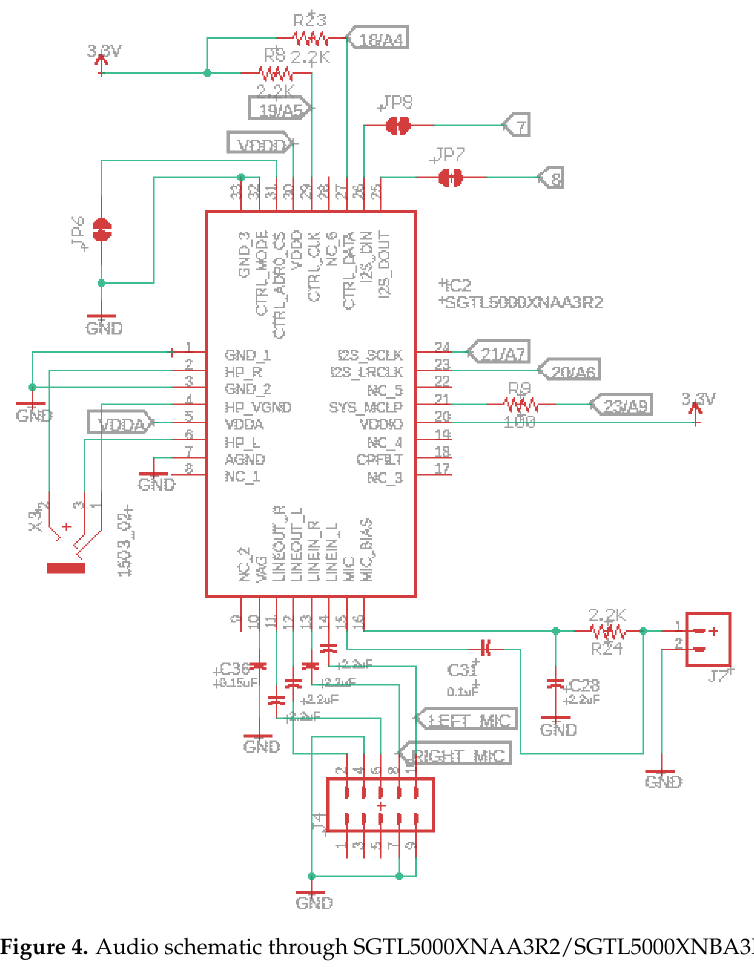
Figure 4. Audio schematic through SGTL5000XNAA3R2/SGTL5000XNBA3R2.